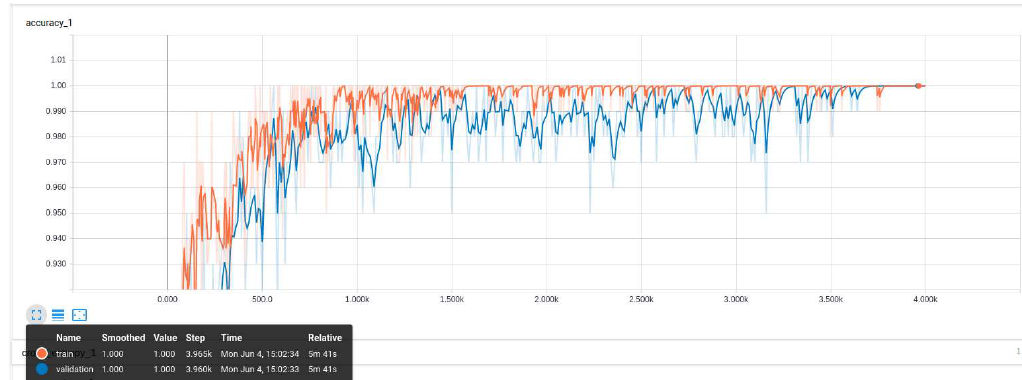
Figure 11. Illustration of the increase in the accuracy over the number of iterations. The training and the validation become stable after 3900 training steps. Sensors 2018 , 18 , x FOR PEER REVIEW